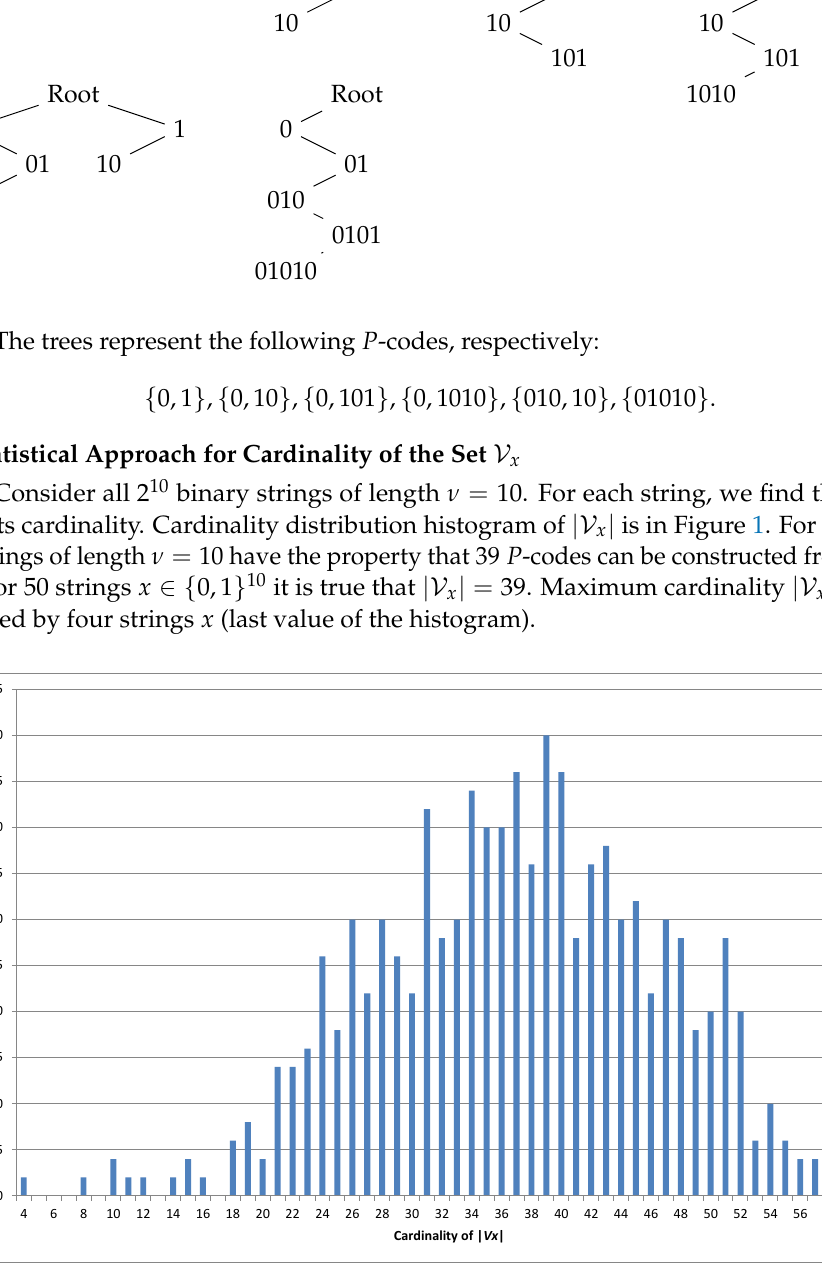
|V | = h ( ν ) = h experimentally x x ∈{ 0,1 } ν